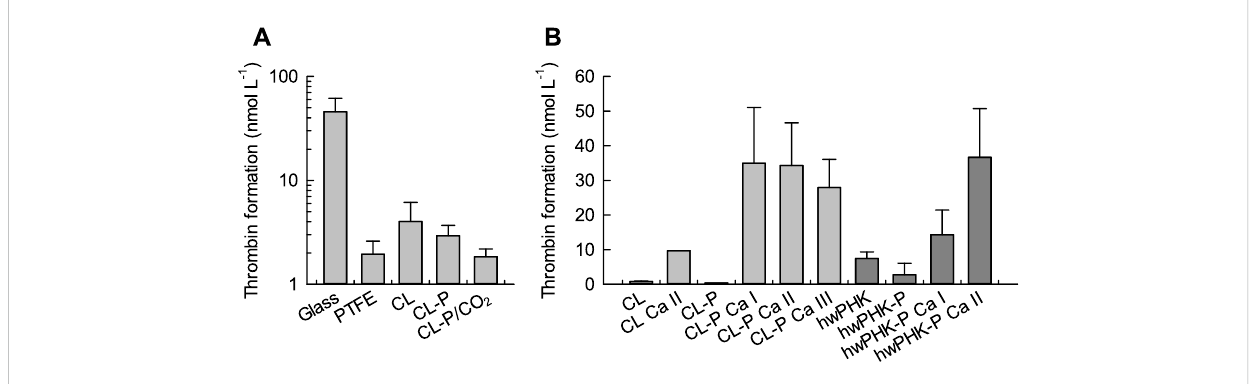
FIGURE 2 Cumulative thrombin activation as marker for plasmatic coagulation activation upon incubation of the cellulosic scaffolds and reference materials with whole human blood. (A) : Pre-study, DS P 0.20, values calculated from Thrombin-antithrombin (TAT) complex concentration. (B) : Phosphorylated and calci fi ed cellulosic materials; data obtained from prothrombin F1+2 fragment release.